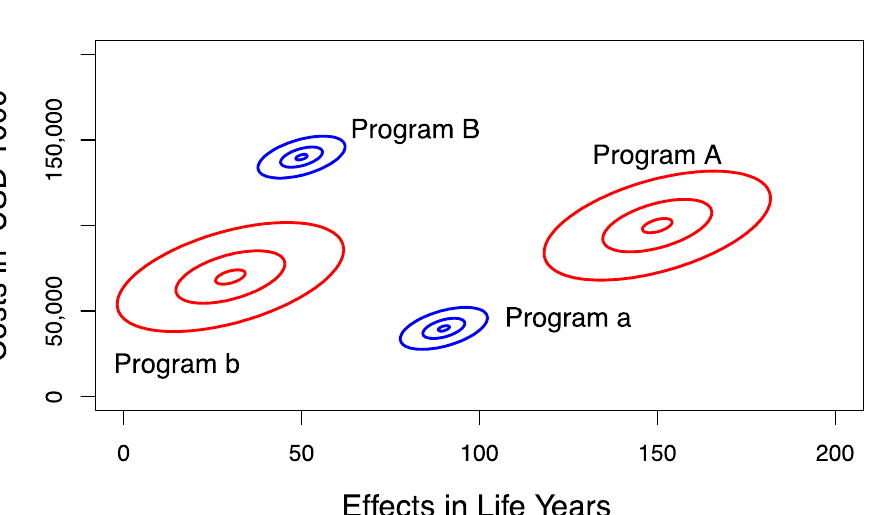
Figure 2. Healthcare resource reallocation while ( a ) decreasing and ( b ) increasing portfolio program uncertainty. The 5%, 50% and 95% credible ellipses for each program are drawn. The portfolio of jointly funded programs is indicated in red and blue colors. Program A and program b (both in red) represent the portfolio of funded programs after resource reallocation, and program B and program a (both in blue) represent the portfolio of funded programs before resource reallocation. By reallocating healthcare resources, program a is replaced by program A , and program B is replaced by program b. See also Scenario 1 and Scenario 2 in Table 2.